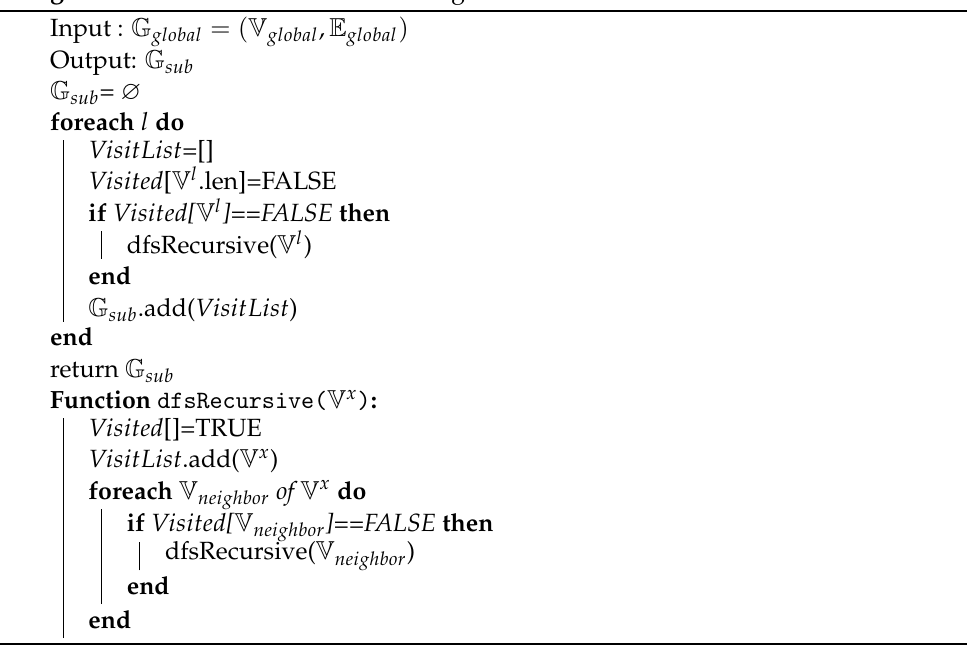
Algorithm 1: Construction of DAG set global